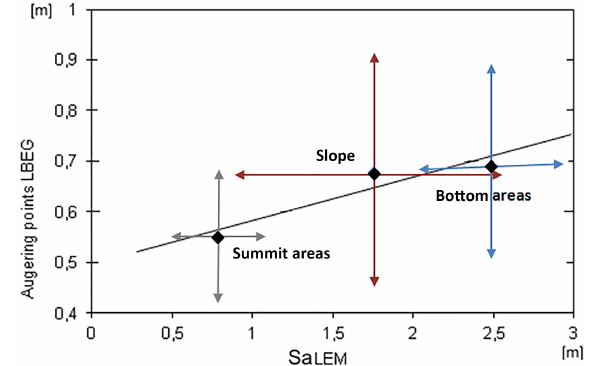
Figure 13. The average regolith thickness values (m) of the drilling points compared to the average values of the SaLEM model run within the units of the geomorphographical map of the validation rectangle. The arrows indicate the standard deviation values of the respective data